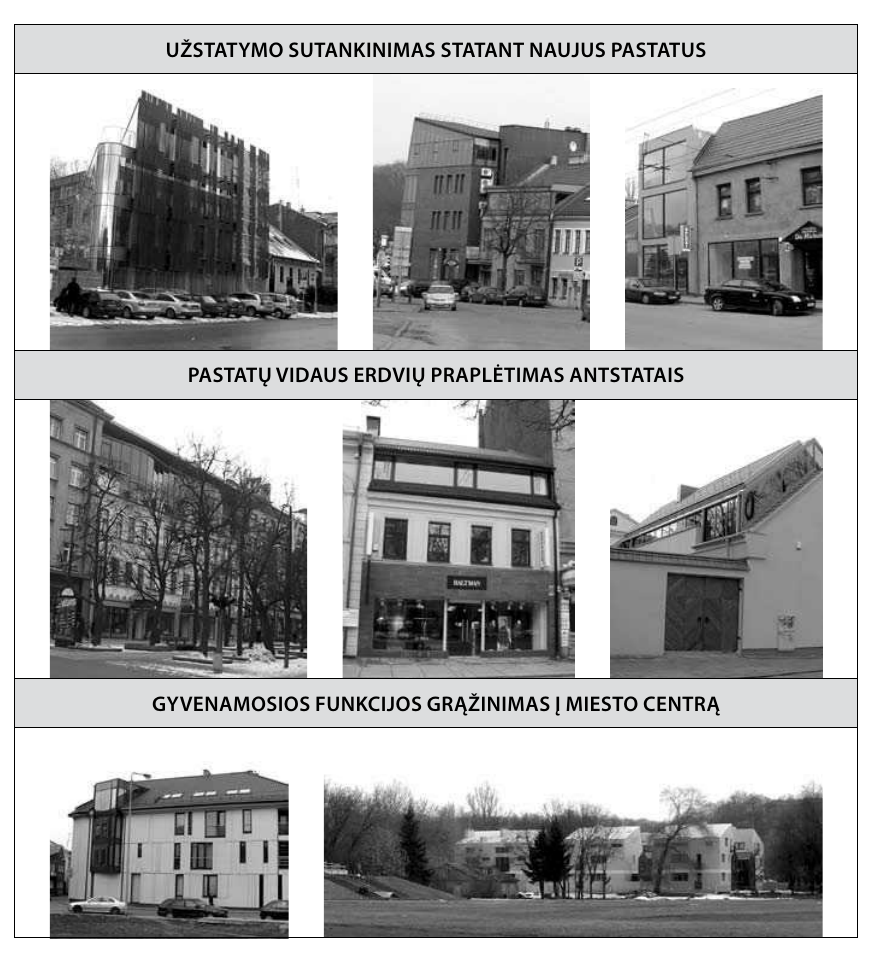
Fig. 2. Processes favourable for sustainable and compact urban development